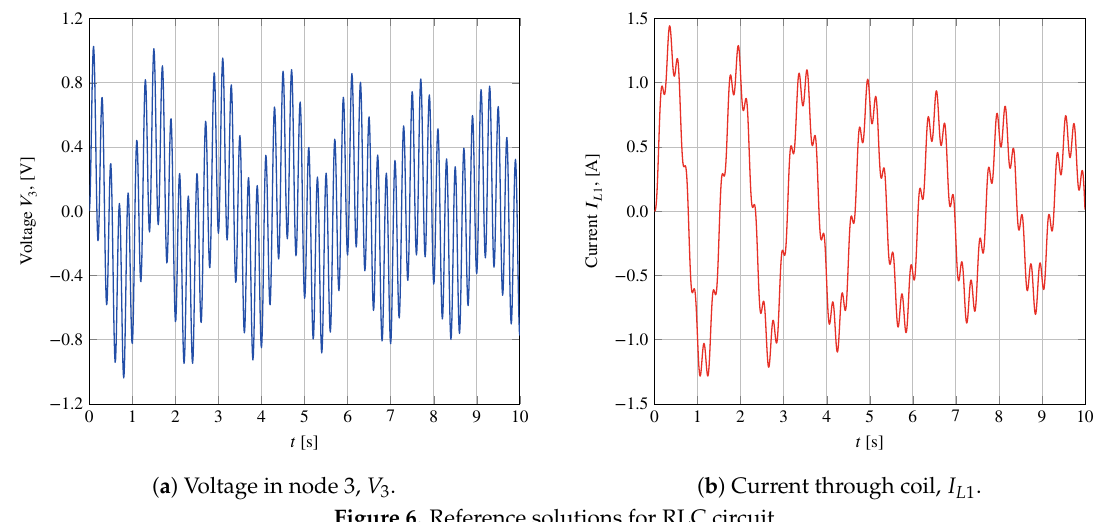
Figure 6. Reference solutions for RLC circuit.